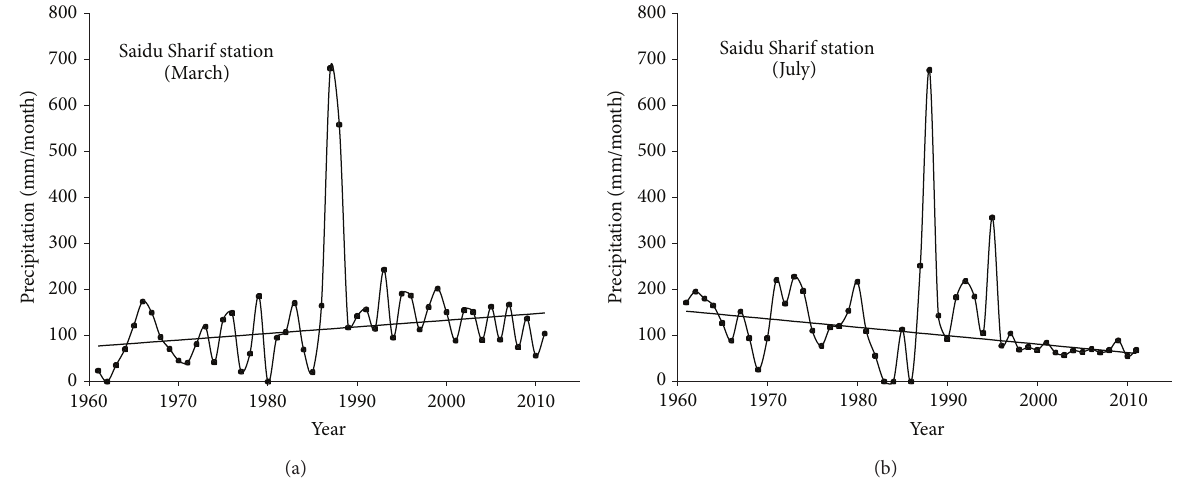
Figure 4: Variations of monthly precipitation time series in stations with most significant trends during 1961–2011.